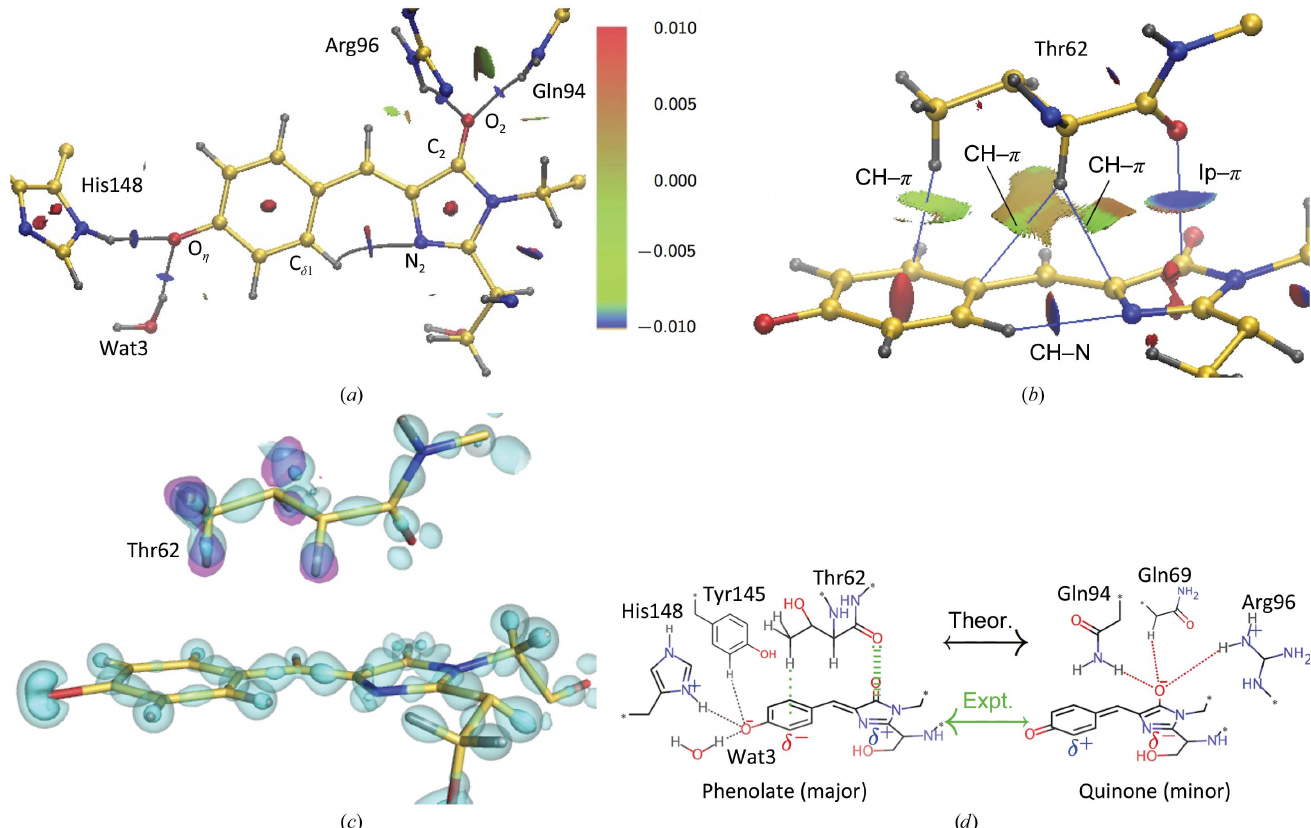
Figure 8 Noncovalent interactions around the chromophore. ( a ) Distribution of the noncovalent interaction surface around the chromophore derived from the MAM. The bond paths for hydrogen bonds are represented as gray curves. The reduced density gradient [ s ( (cid:6) ) = 0.4] isosurface is colored according to a blue–green–red scale over the range (cid:5) 0.01 < sign( (cid:12) 2 ) (cid:6) < +0.01 e a 0 (cid:5) 3 . (cid:12) 2 and a 0 are the second eigenvalue of the Hessian and the Bohr radius, respectively. Blue indicates attraction, green indicates very weak attraction and red indicates repulsion. ( b ) A side view of the interaction surfaces. The abbreviation ‘lp’ is short for ‘lone pair’. ( c ) The distribution of interacting electrons in the corresponding region to ( b ). The cyan surface represents the deformation electron density at contour levels of +0.2 and +0.5 e A˚ (cid:5) 3 . The pink surface represents the F o (cid:5) F c OMIT map for H atoms of Thr62 contoured at 3.5 (cid:5) . ( d ) A schematic representation of the resonance structure of the anionic chromophore. Interactions stabilizing each resonance state are indicated. The preceding theoretical calculations predicted that the quinone form is favored (Fig. 4) or that both states are almost equivalent (Martin et al. , 2004; Petrone et al. , 2013), while the phenolate form was predominant in our